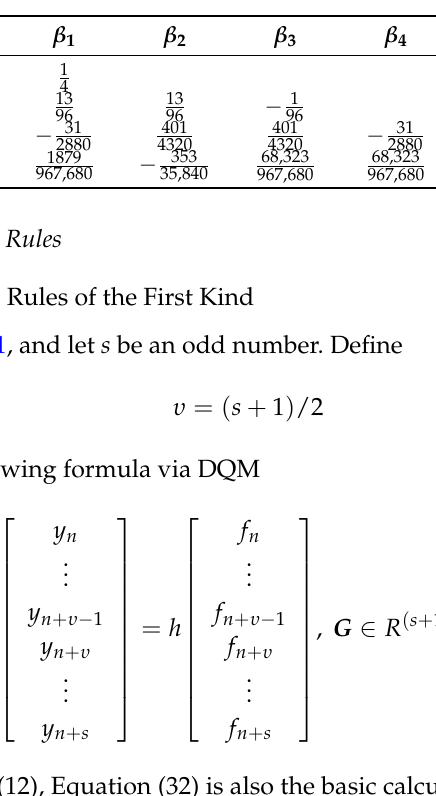
Table 5. Coefficients of GAMs using uniform grids (for odd s